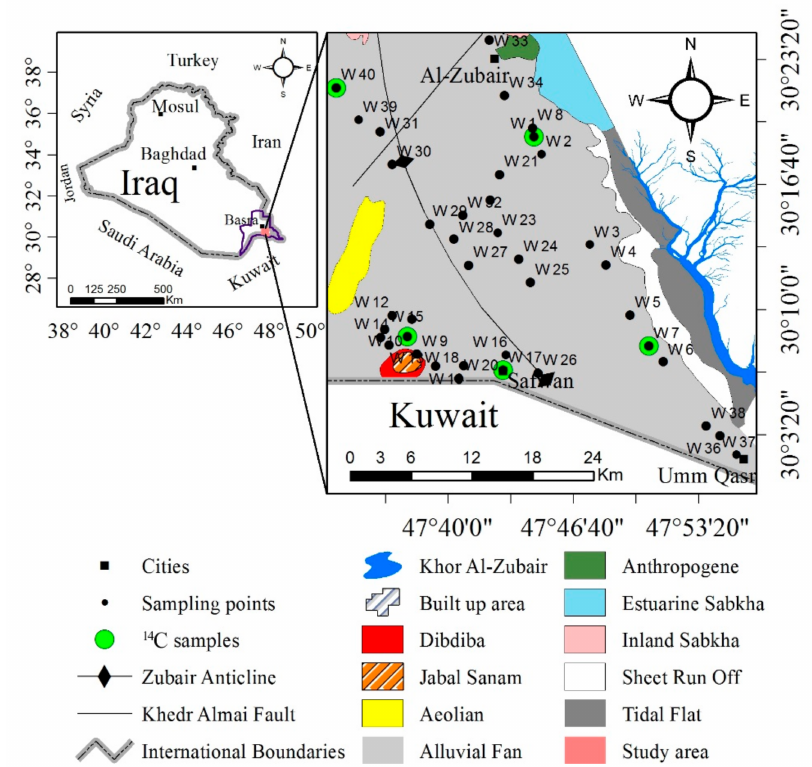
Figure 1. Map of the study area. Upper left: map of Iraq showing borders with neighboring countries (Jordan, Syria, Turkey, Iran, Kuwait, and Saudi Arabia) and the study area (red spot). Right: Geological map of the AOI with hydrochemistry points (black dots), main cities (black squares), Khor Al-Zubair channel, 14 C sampling points (green dots), the Zubair anticline, and Khedr Almai Fault after